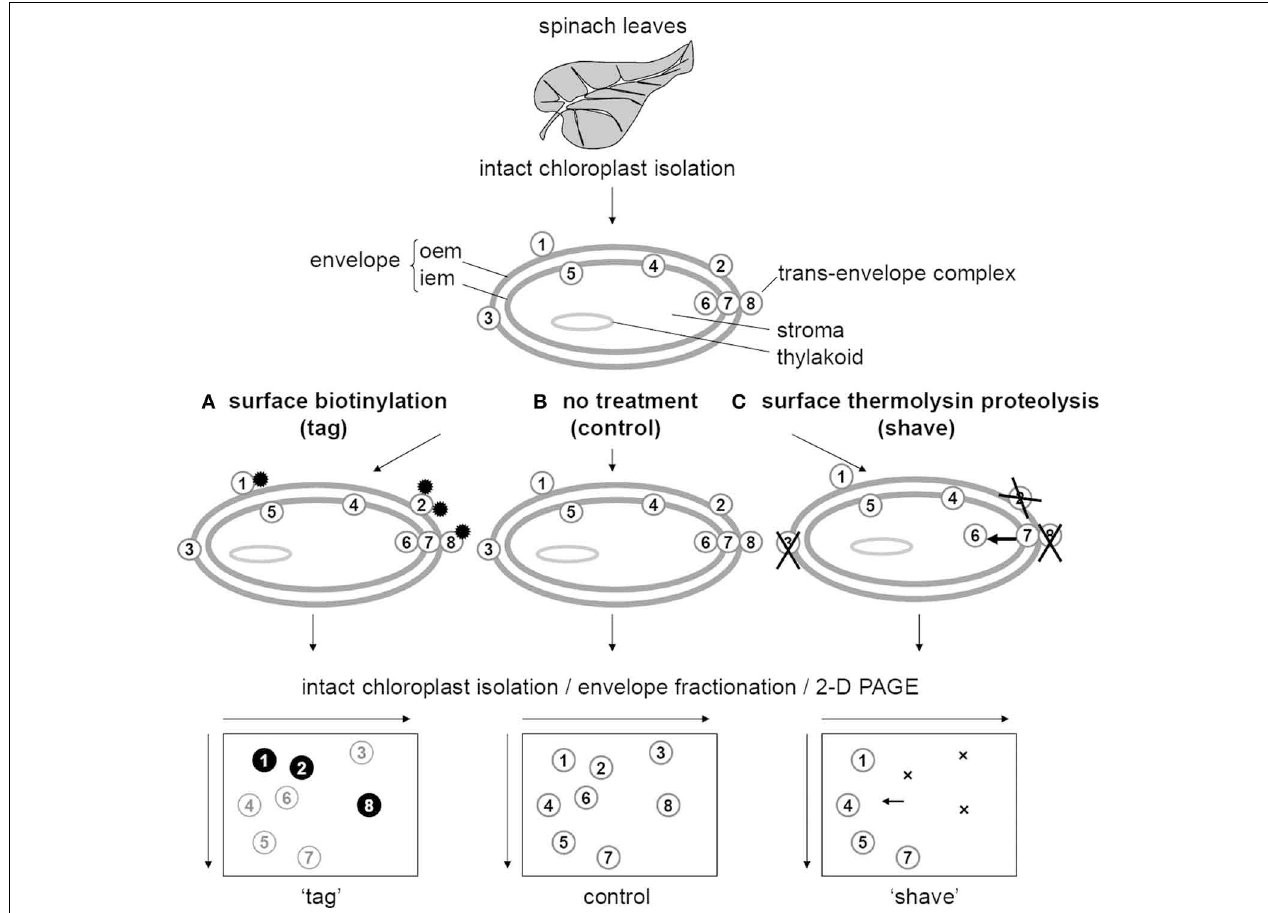
FIGURE 6 | Topological information possibly provided by the tag and shave strategy, coupled with 2D-PAGE proteomic analyses. Chloroplasts isolated from leaves are either superficially tagged with biotin (A) , superficially shaved by proteolysis with thermolysin (C) or untreated (B) . (A) Outer envelope membrane (OEM) proteins that are possibly biotinylated are detected after biotin detection (proteins 1, 2, and 8), whereas OEM proteins that fail to be biotinylated are not tagged under these conditions (protein 3). Internal proteins (proteins 4, 5, 6, and 7) are not tagged. (C) Outer